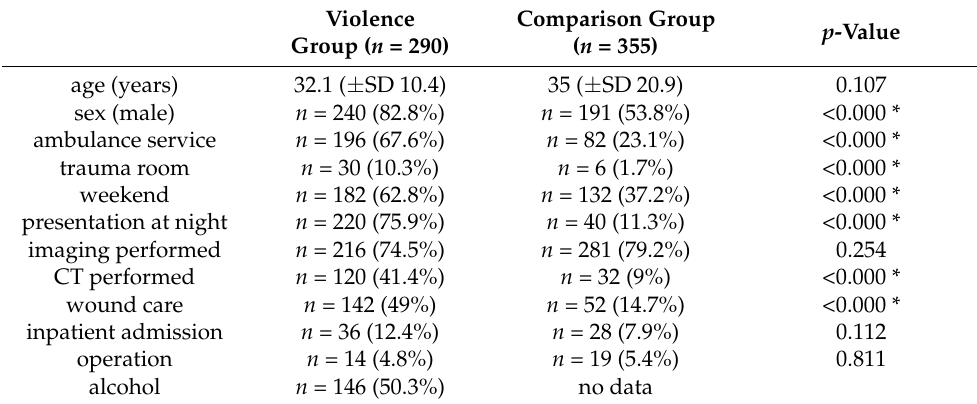
Table 2. Demographics, preclinical and clinical